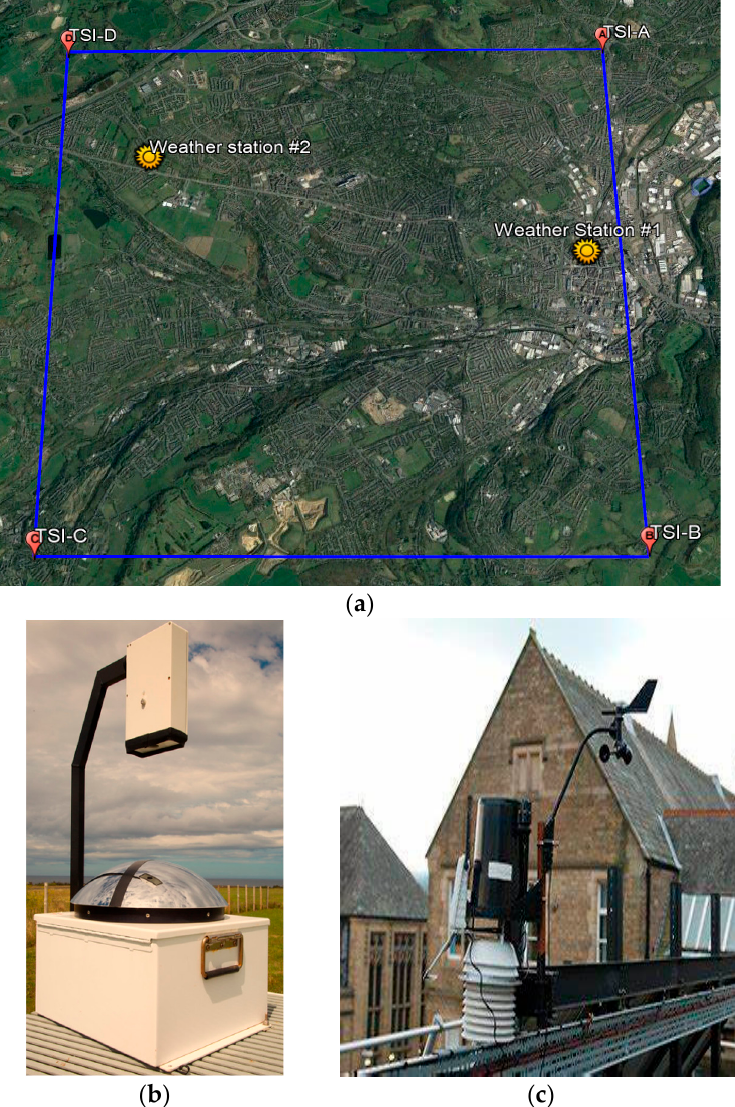
Figure 2. Experimental setup: ( a ) Map showing the sky imager locations and the weather stations. The actual distance from TSI-A to TSI-B was 5 km. The region displayed in this figure was approx- imately 5 km 2 , taken from @Google Maps, 2022, ( b ) TSI 440A total-sky imager, ( c ) Davis weather station.